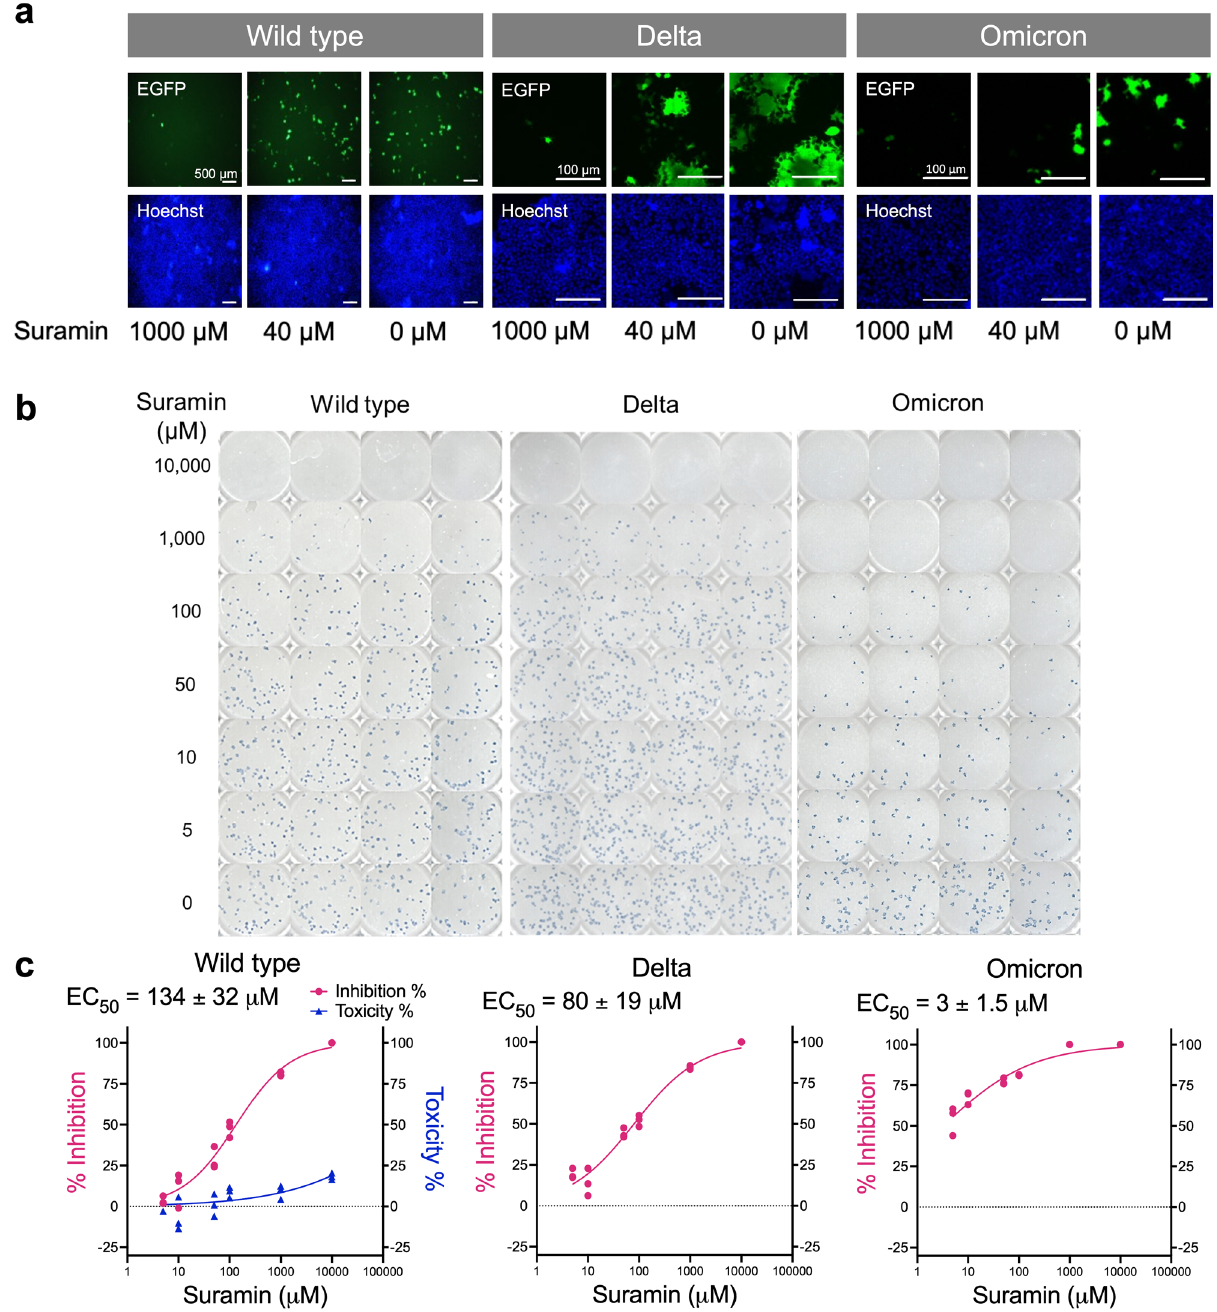
Fig. 4 Assessment of antiviral activities of suramin. a In vitro SARS-CoV-2 pseudotyped viral particle neutralization assays against wild type (WT), Delta, and Omicron variants. Representative fl uorescence microscopy images as a function of suramin concentration. b Focus reduction assay images of the infection by live SARS-CoV-2 variants upon treatment of suramin. At 2-days after infection, Vero cells were fi xed and probed with SARS-CoV-2 spike primary antibody (1:10000, Sino Bio Inc.) and HRP-conjugated goat rabbit (1:10000, Abcam) secondary antibody. c Vero cells were infected with SARS- CoV-2 at a 50 focus-forming unit (FFU) of wild type at different doses of suramin for 48 h. The viral yield was quanti fi ed using a focus reduction assay. Cytotoxicity in Vero cells was measured using the WST-1 assay. The left and right y-axes represent mean percent inhibition of virus yield and cytotoxicity of the polysaccharides,